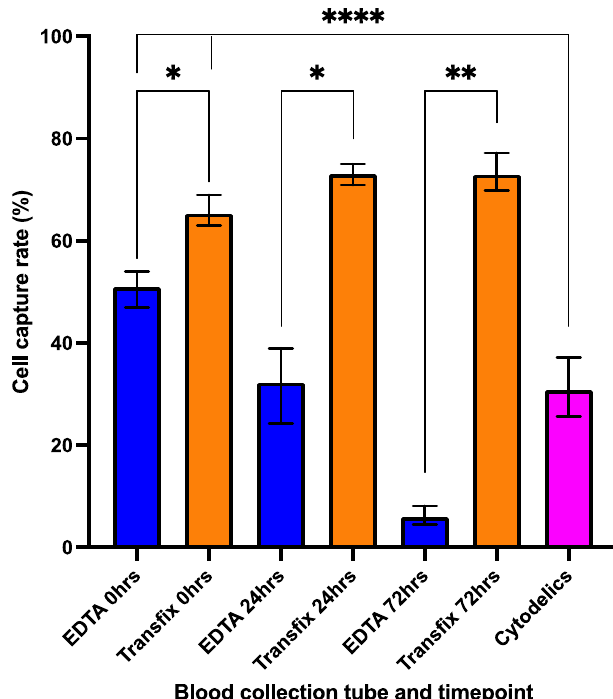
Figure 3. Improved cell capture rate with Transfix compared to EDTA and Cytodelics. Healthy donor (HD) blood (9 mL) collected into EDTA or Transfix Blood collection tubes and spiked with 100 cells/mL (target concentration), then enriched using Parsortix at timepoints 0 h, 24 h or 72 h. 1 mL of HD blood spiked with 100 cells and preserved using Cytodelics protocol and frozen to − 80 °C prior to thawing and processing. Bar denotes mean cell capture rate and whiskers range of values for n = 3 (EDTA, Transfix) or n = 5 (Cytodelics experiments). (* = p < 0.05, ** = p < 0.001, **** = p < 0.0001).